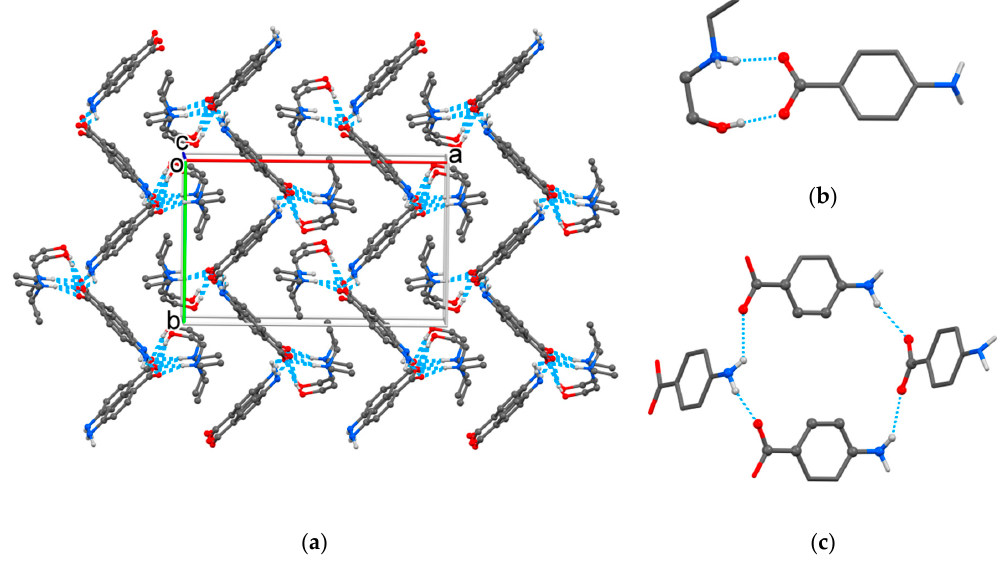
Figure 2. The crystal packing of HEEA- p ABA ( a ) with representation of R 22 (9) heterosynthon ( b ) and R 44 (22) homosynthon in crystal ( c ). Table 2. Hydrogen bond distances (Å) and angles (°) in HEEA- p ABA and HDEEA- p ABA. D ‒ H ∙∙∙ A